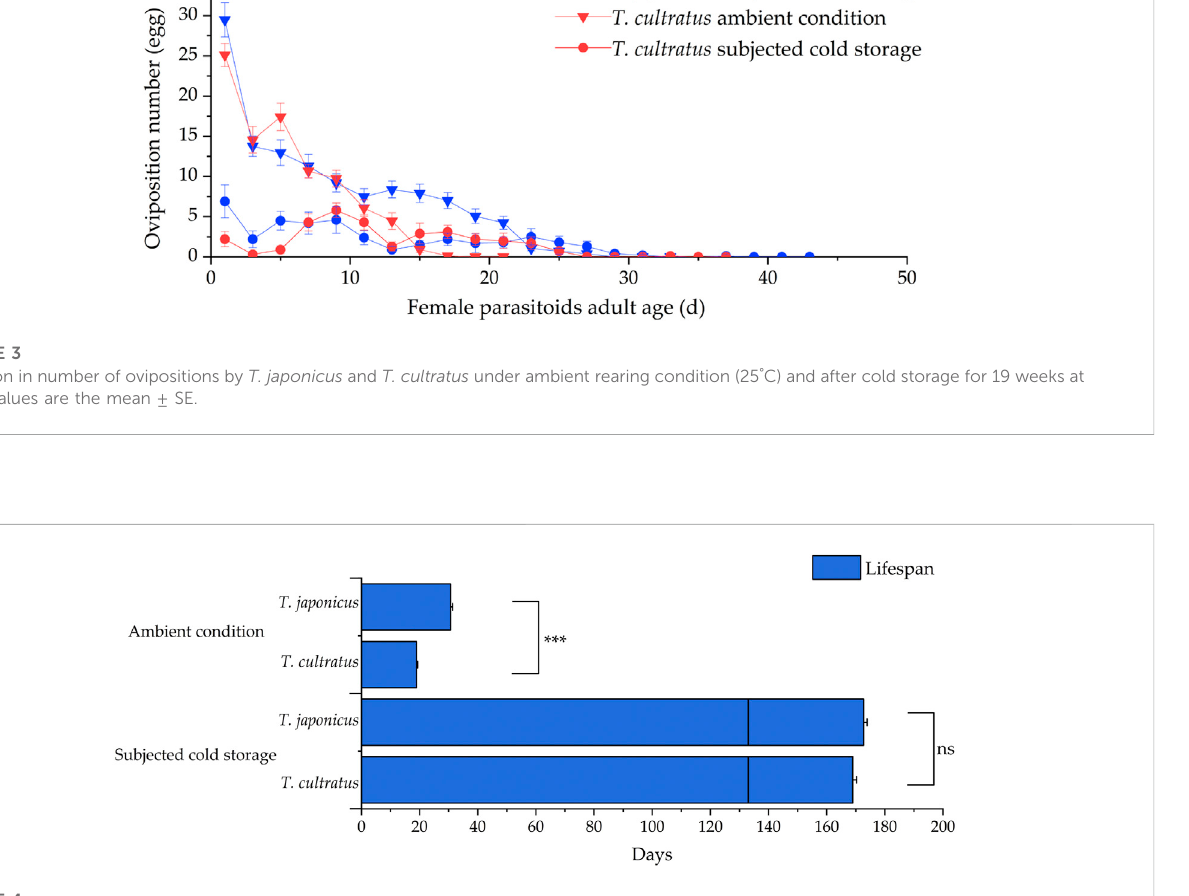
FIGURE 4 Mean lifespan of T. japonicus and T. cultratus when under ambient rearing conditions (25 ° C) and extended by cold storage. Values are means ± SE. Asterisks represent statistically signi fi cant differences, and ns present no signi fi cant difference between T. japonicus and T. cultratus within the same treatment (*** p <